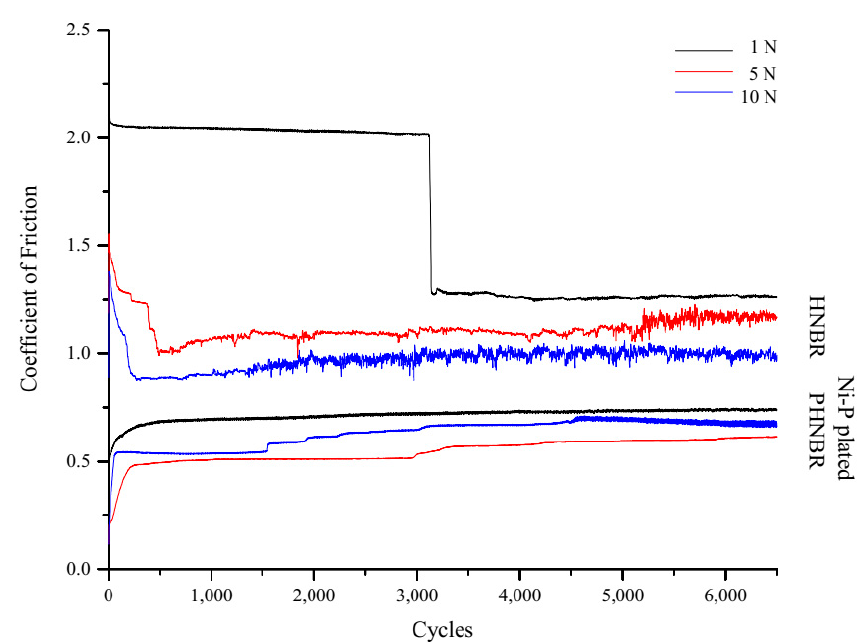
Figure 13. Variation of the coefficient of friction as a function of cycles for pristine HNBR and Ni-P plated PHNBR for one of three samples tested for each load.